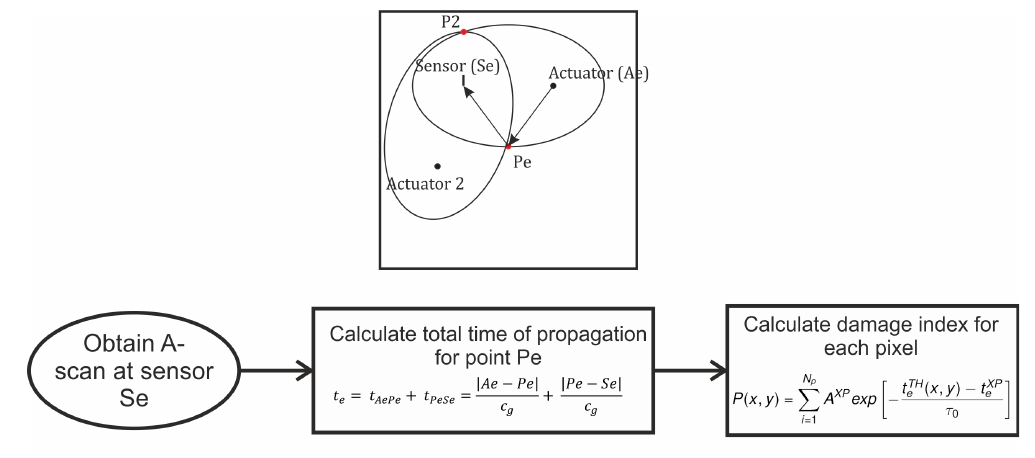
Figure 1. Amplitude weighted ellipse approach for damage hotspot